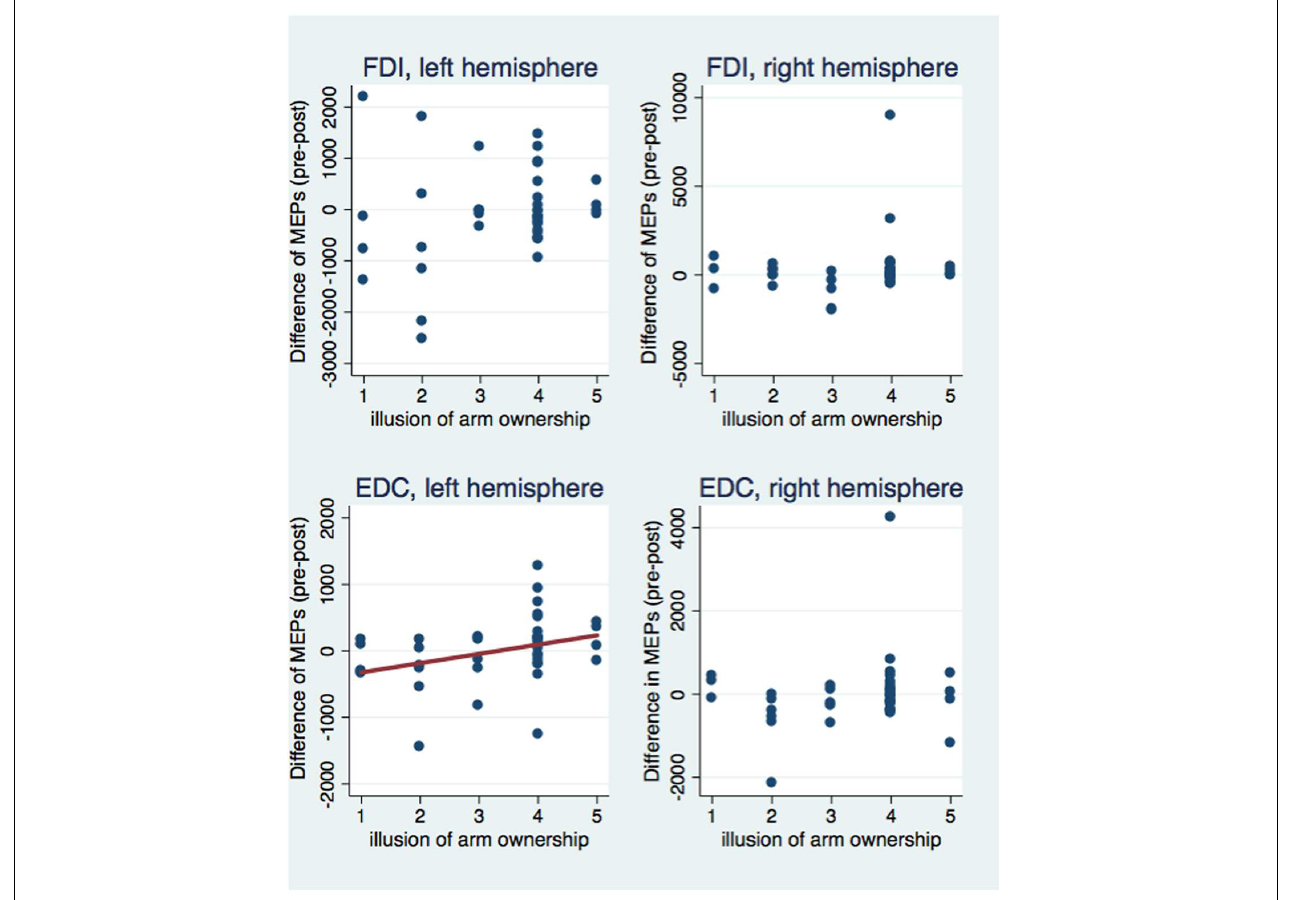
FIGURE 6 | Scatterplot of the difference between pre and post-VR MEP amplitudes with the illusion of arm ownership per each muscle and hemisphere. The difference in amplitudes was significantly correlated with the arm ownership illusion only for the EDC muscle of the left hemisphere (see text). Similarly, only in this case, the ownership illusion predicted significantly the MEPs’ difference ( b = 139.27, t = 2.10, p = 0.043) and explained a significant proportion of its variance [ R 2 = 0.08, F ( 1 , 37 ) = 4.40, p =